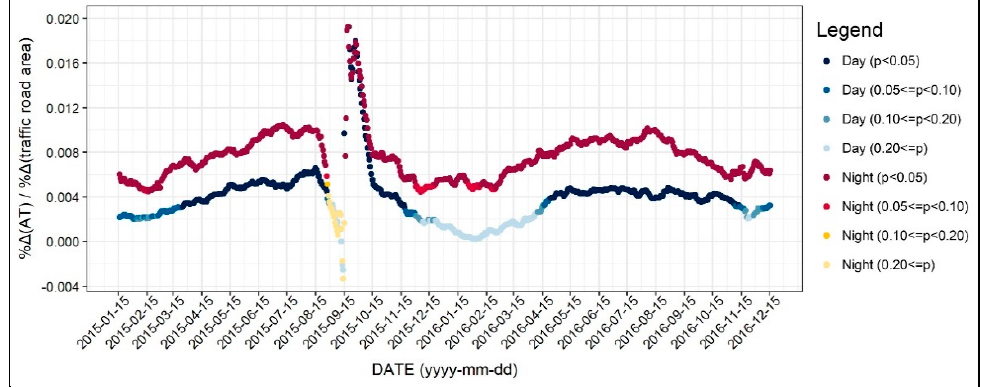
Figure 12. Changing patterns in the regression coefficients and their significances (traffic road area).